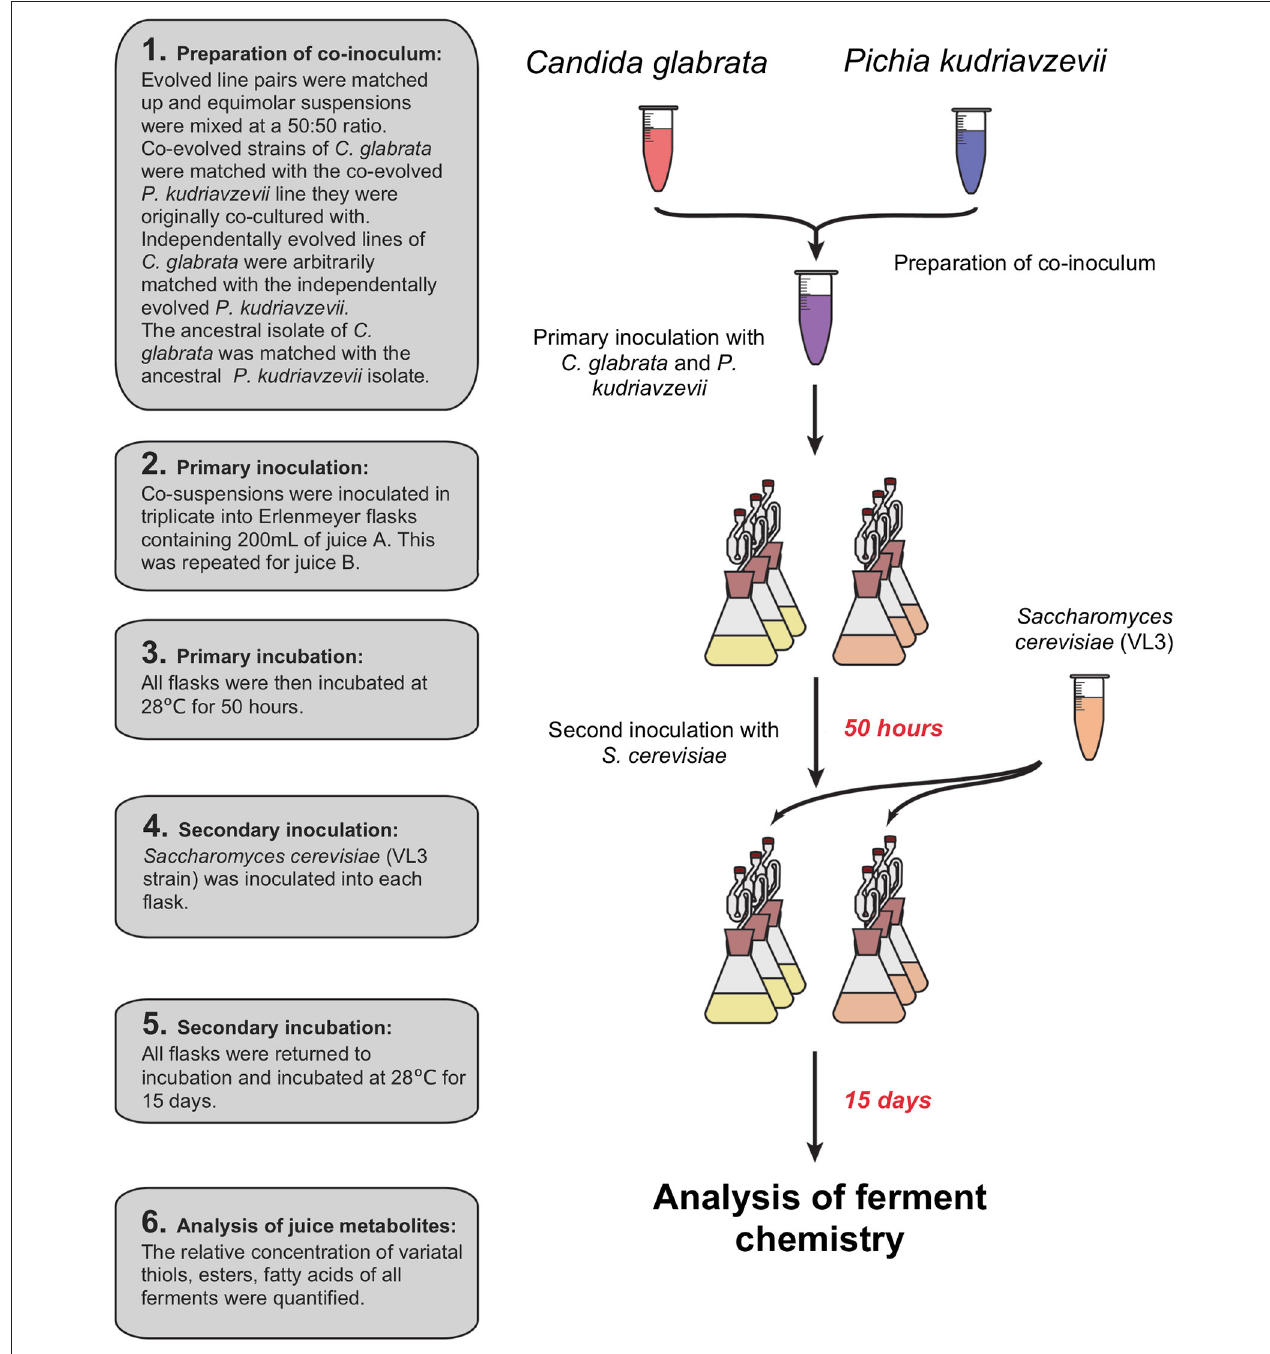
FIGURE 2 | Sequential inoculation of experimental ferments: primary inoculation of C. glabrata and P. kudriavzevii pairs then a secondary inoculation of S. cerevisiae after 50h.